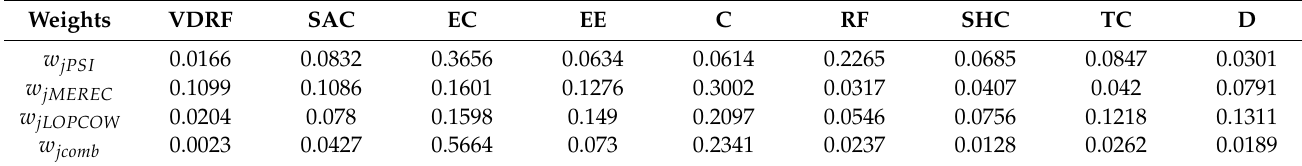
Table 6. Criteria weights.